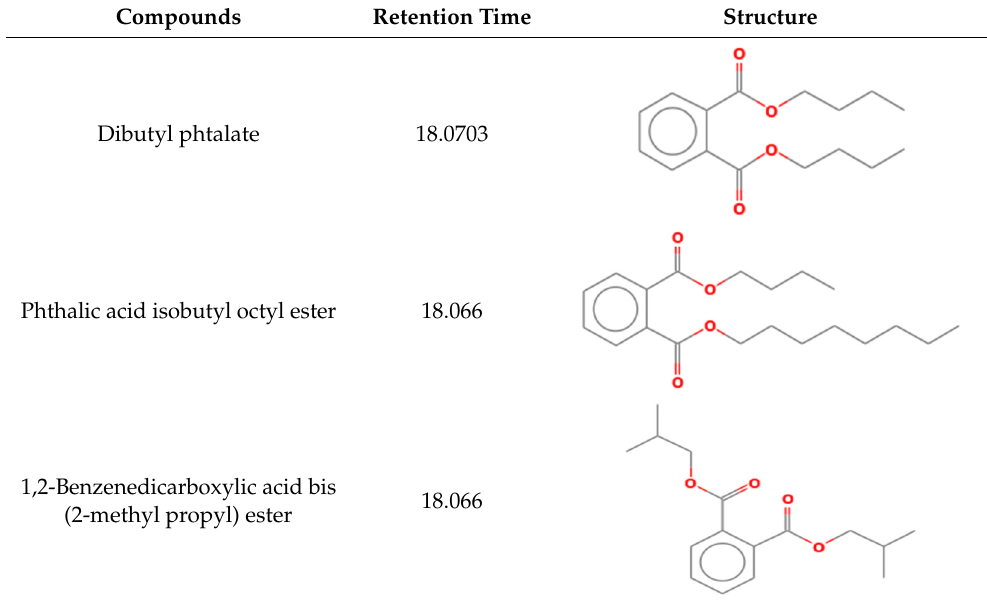
Table 5. Compounds identified by GC/MS analysis after the applied Fenton treatment.